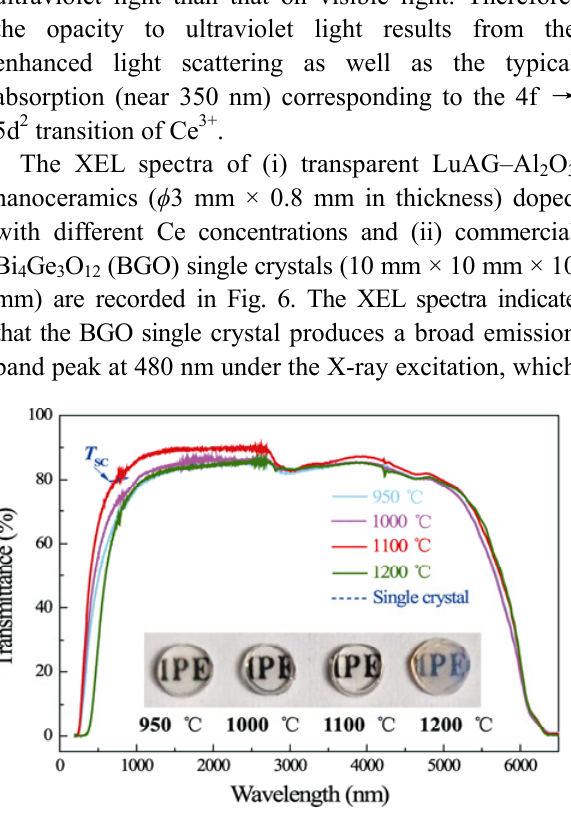
Fig. 4 In-line transmittance spectra of transparent materials (1.0 mm in thickness) crystalized from ALu28 glass-based precursors at 950, 1000, 1100, and 1200 ℃ for 2 h. The inset is their picture.